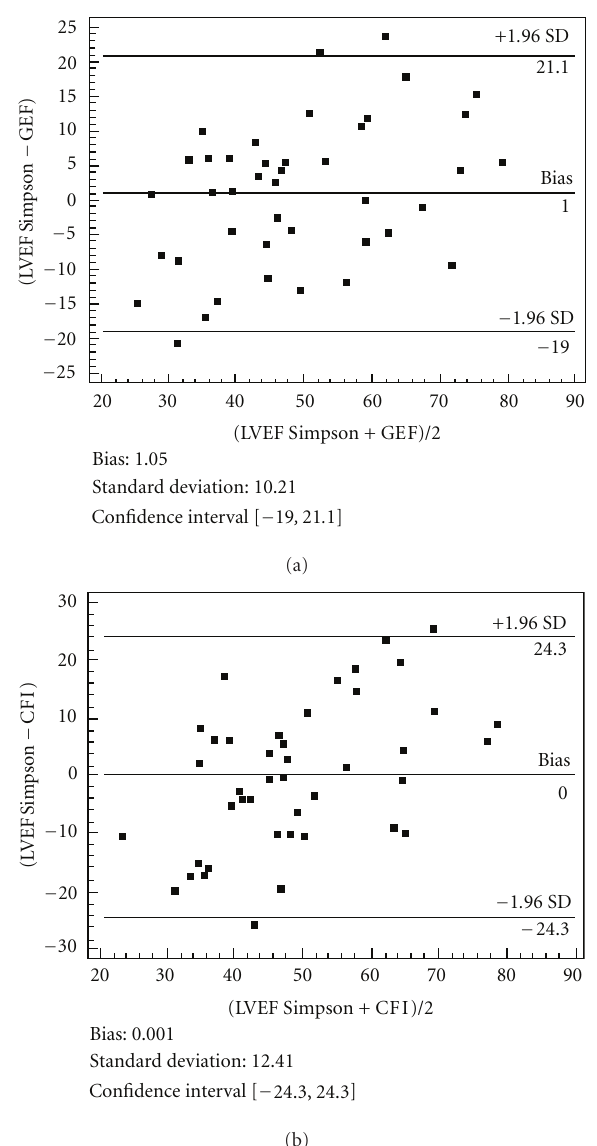
Figure 1: Bland-Altman analyses of agreement between GEF (a) or CFI (b) and the LVEF measured by the Simpson method. The central line is the mean di ff erence (bias) between the two methods whereas the outer lines represent the two SD limits of agreement. From Belda et al. [18] with